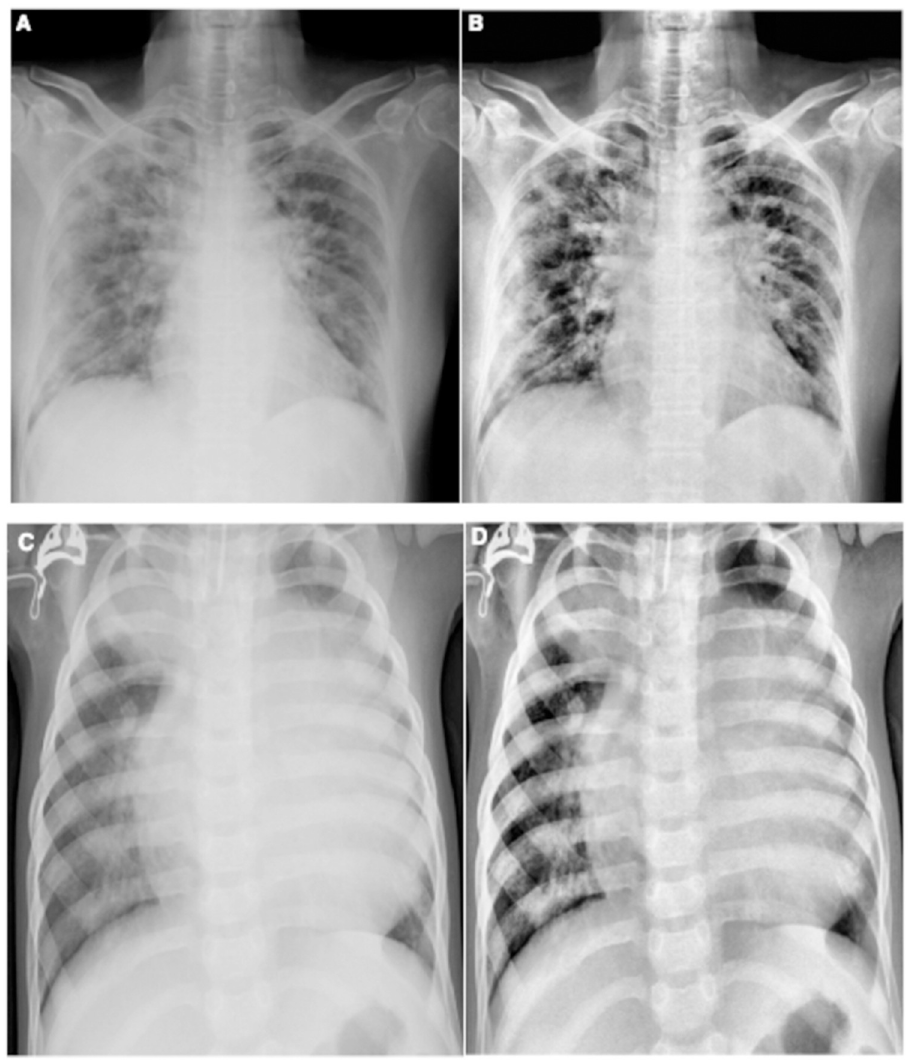
Fig 6. (A) and (C) original chest x-ray COVID-19 and Pneumonia images; (B) and (D) contrast enhanced image using I comb